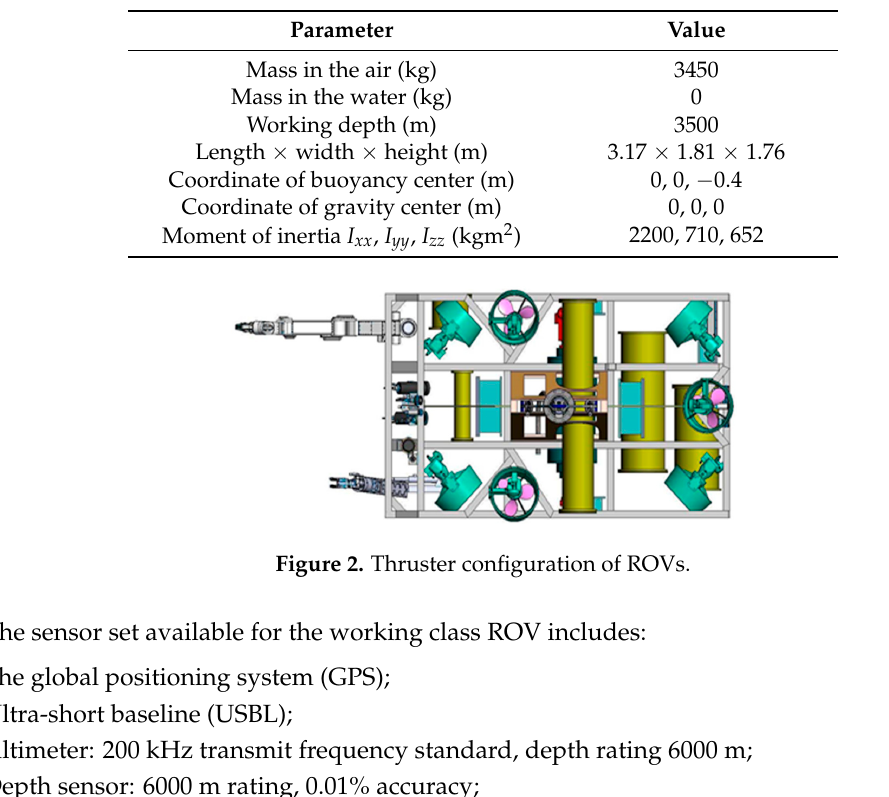
Table 1. Main parameters of the ROV.